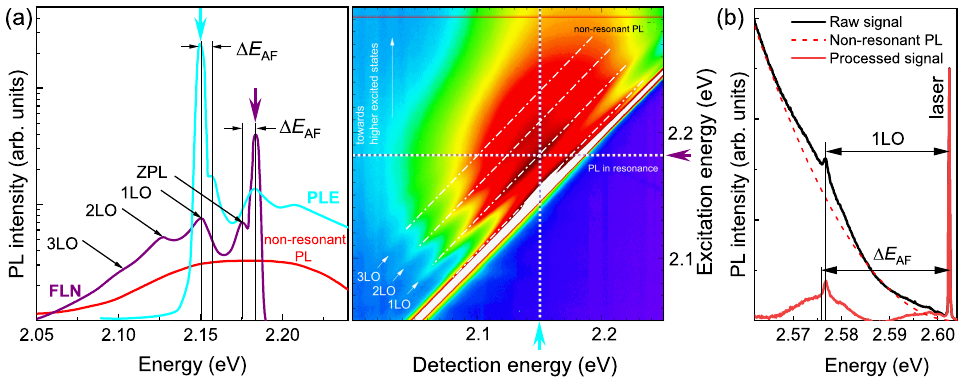
Figure 2. ( a ) FLN/PLE spectra obtained using excitation by a Hg lamp. ( Left panel ) FLN and PLE spectra measured with excitation and detection energies marked by the purple and cyan arrows in the hyperspectrum. ( Right panel ) FLN/PLE hyperspectrum for zb-CdSe NCs with a mean radius R = 2 nm. ( b ) FLN spectrum for zb-CdSe NCs with R = 1.6 nm obtained using excitation by an Ar ion laser. The shifts of the optical phonon-scattered laser light and dark exciton emissions are marked as 1LO and ∆ E AF ,